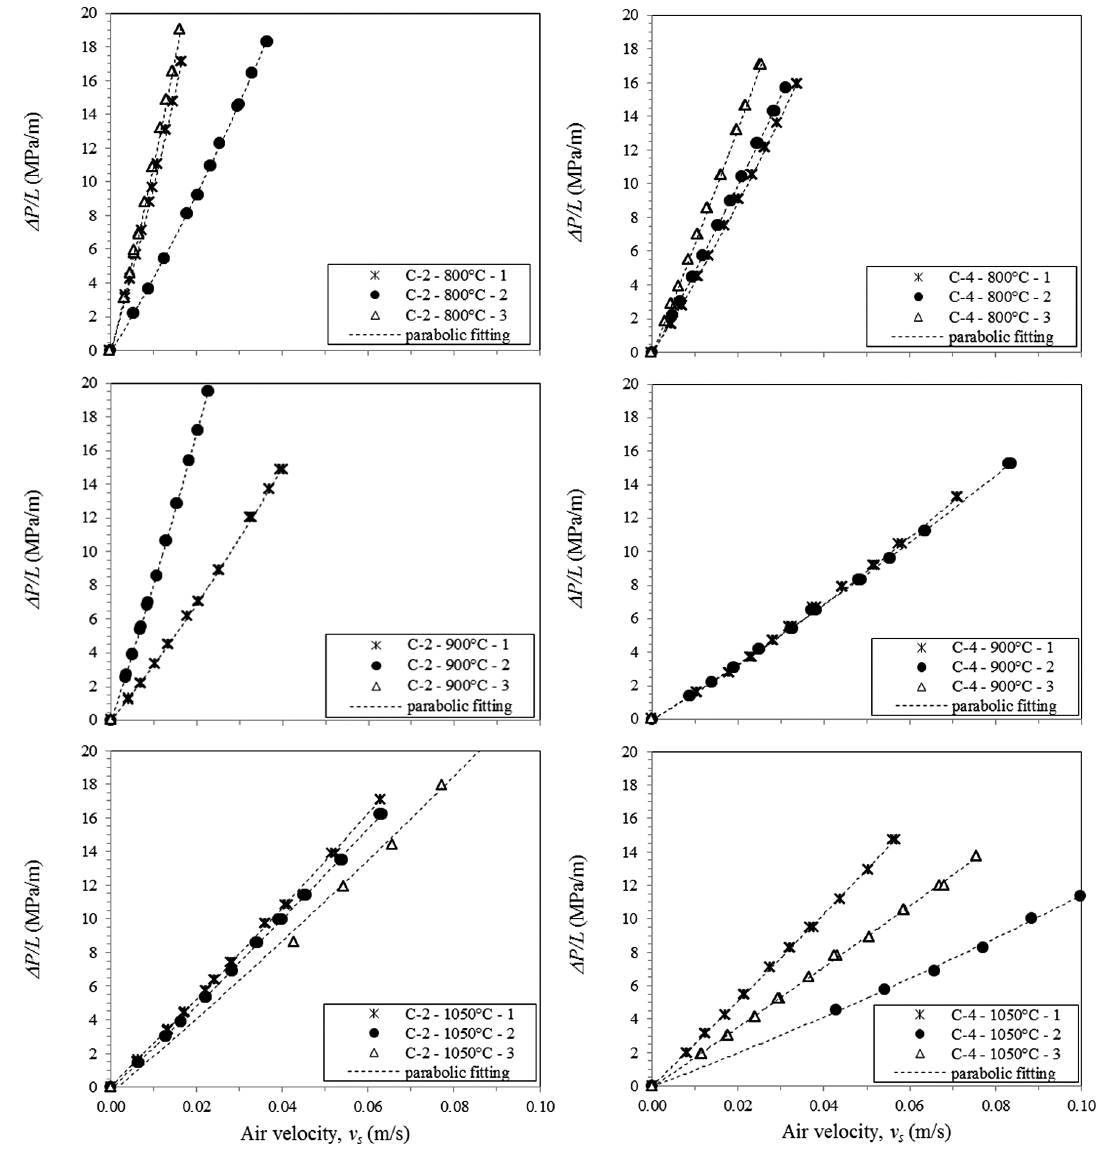
Figure 5. Air permeation plots of compositions C-2 and